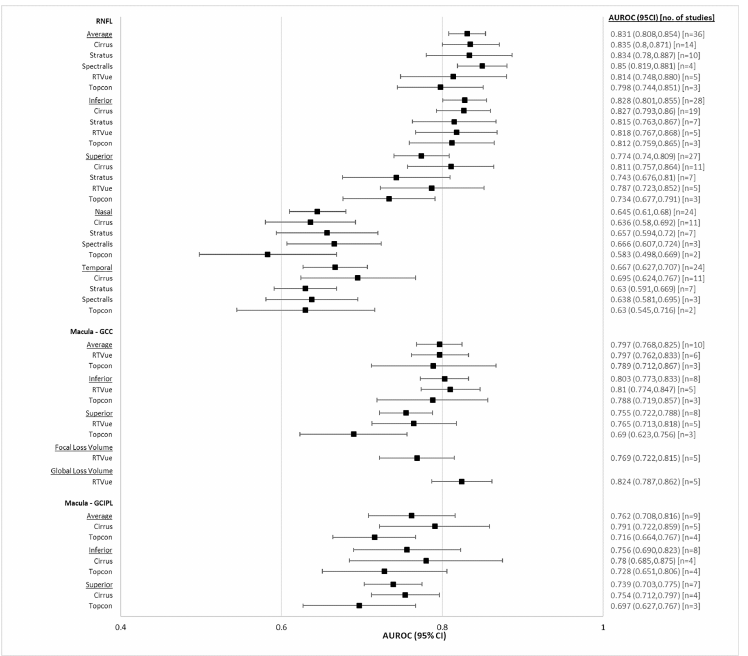
Fig 5. Forest plot of diagnostic accuraciesof RNFL and macular OCT parameters, pre-perimetric